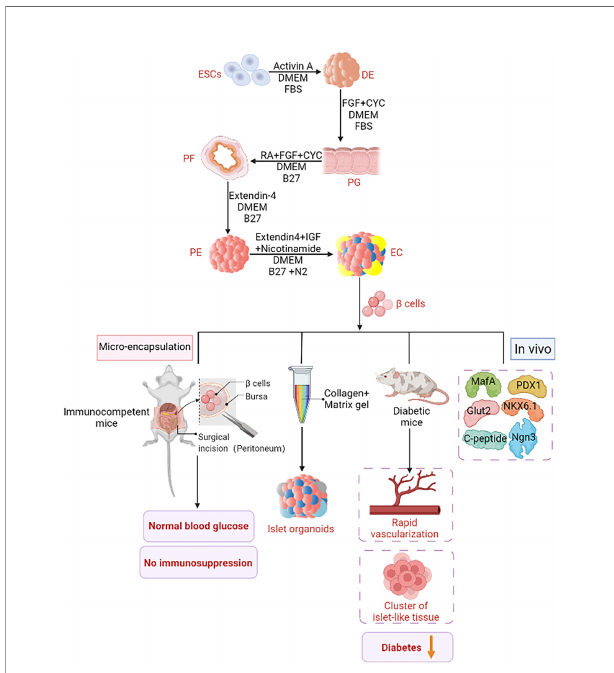
FIGURE 3 | ESCs derived insulin supplement. An improved ESCs pancreatic differentiation protocol was developped. First, under the action of Activin A, DMEM, and FBS, one de fi nitive endoderm (DE) was established through mesoderm. In the second step, activin A was removed and kaad-cycloamine (CYC) and fi broblast growth factor (FGF) were added to facilitate the transition from DE to the primitive gut tube (PG). The third step is to add retinoic acid (RA) and B27, and then to the posterior foregut endoderm (PF). Step 4: Extendin 4 (EX4) was added to support pancreatic lineage speci fi c differentiation. The fi fth step is to generate endocrine cells under the stimulation of EX4, IGF (insulin-like growth factor) and nicotinamide. These cells differentiate in vitro into insulin- secreting cells, Pancreatic and duodenal homeobox 1 (PDX1), neurogenin 3 (Ngn3), MAF BZIP Transcription Factor A (MafA), glucose transporter 2 (Glut2), NK6 Homeobox 1 (NKX6-1) and C peptide were expressed. When these cells are injected into diabetic mice, diabetes is effectively ameliorated by rapid vascularization and the formation of a cluster of islet organoids. Islet organoids are obtained from ESCs by combining collagen and matrix gel in the biomimetic 3D scaffold. Islet sacking can quickly restore normal blood glucose without